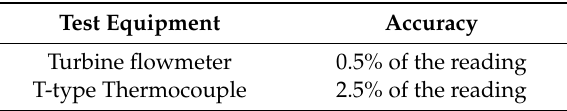
Table 2. Specification of test